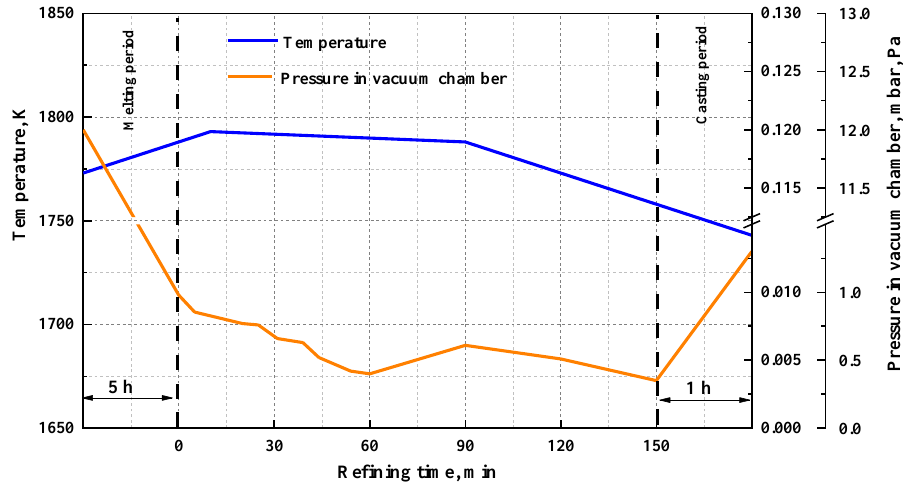
Figure 3. Operation curves of temperature and pressure at different stages.